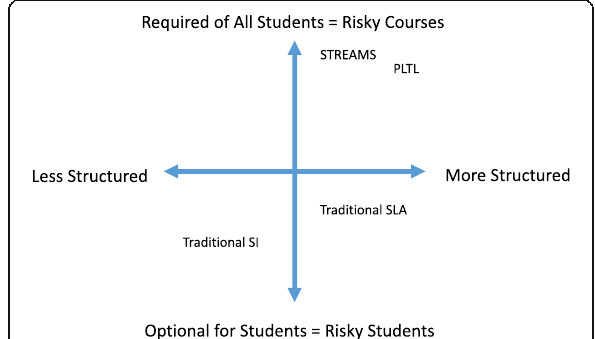
Fig. 1 Conceptual representation of different forms of peer-cooperative learning programs, based on two dimensions: how structured the meeting time for small group is and how students enter the program. Traditional Supplemental Instruction (SI), traditional Structured Learning Assistance (SLA), Peer-Led Team Learning (PLTL) and the aggregate of the STREAMS programs at BSU are